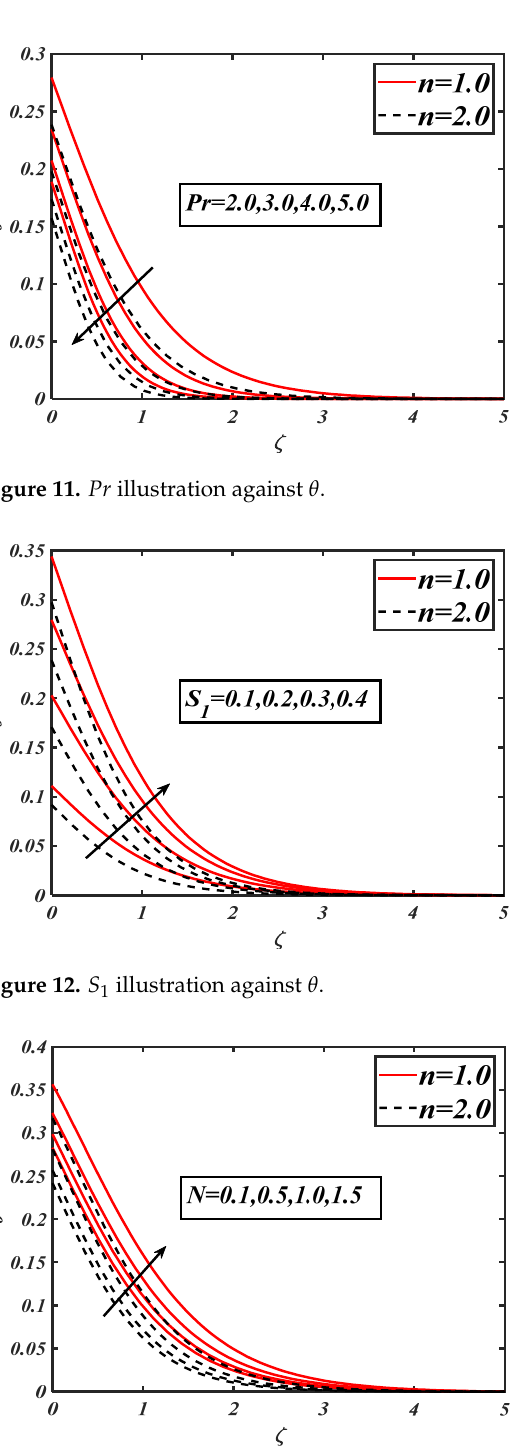
α α illustration against g illustration against g